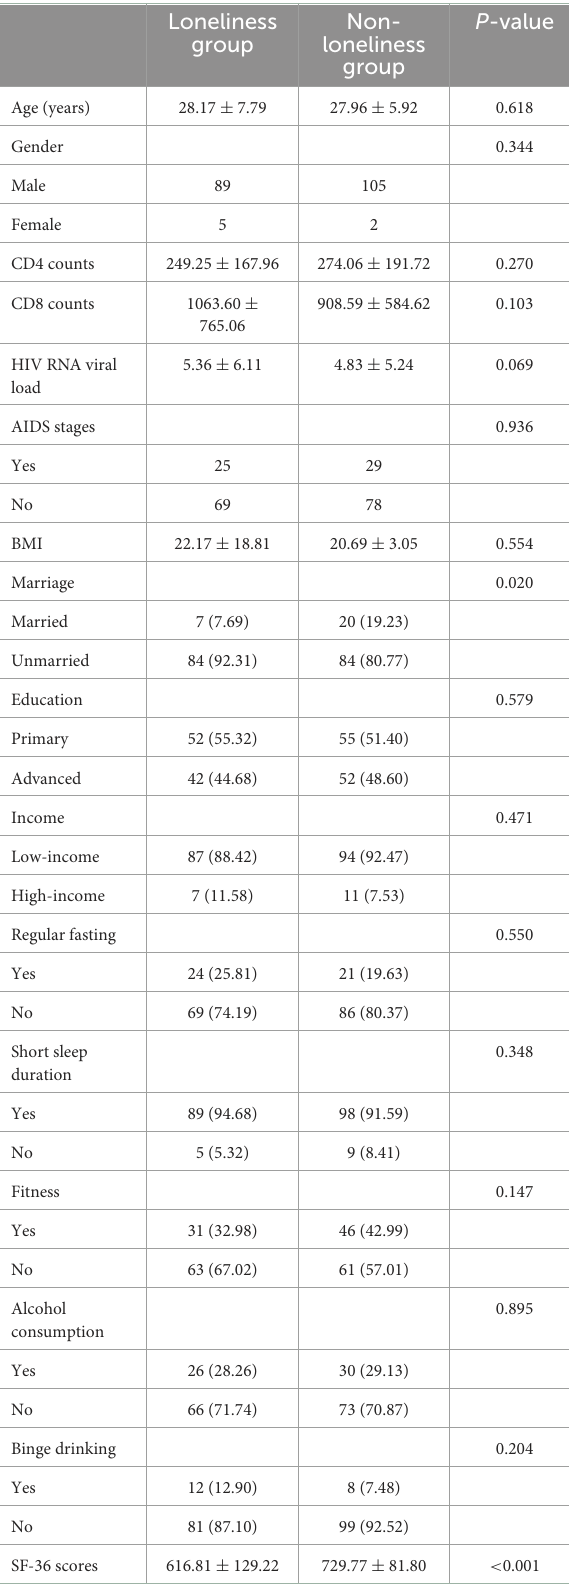
TABLE 1 Baseline characteristics of loneliness group and non-loneliness